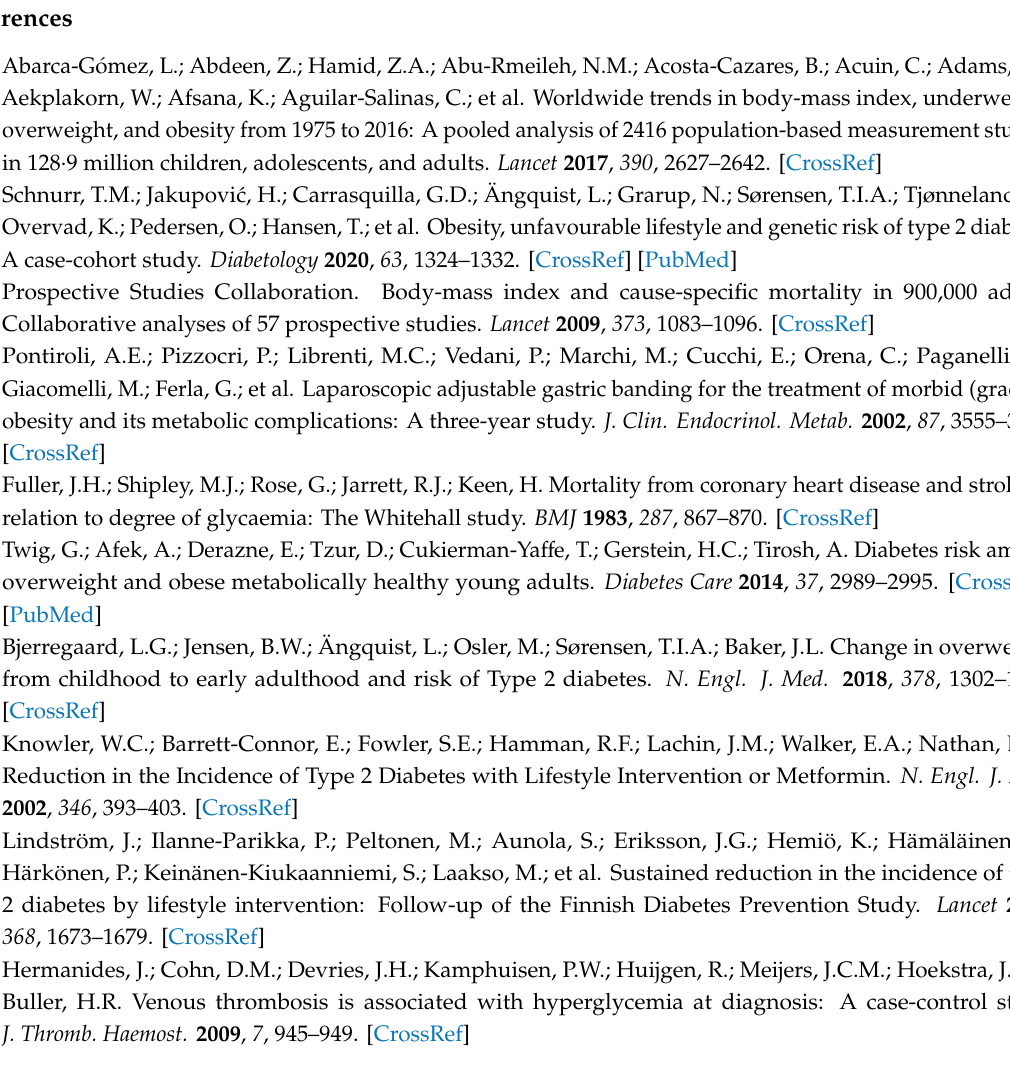
Figure A1. Major contributors of T2D / Obesity driving toward to dysregulation of target tissues.